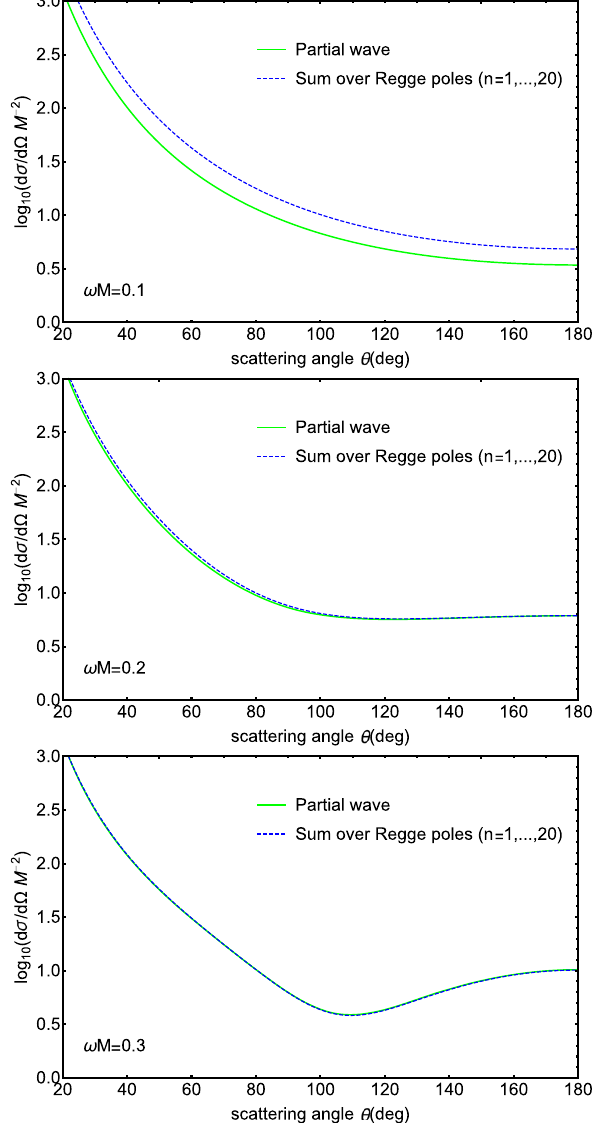
Fig. 9 Comparison of the scattering cross sections obtained via the partial wave method and the Regge pole approximations for ω M = 0 . 1 (top), 0.2 (middle), and 0.3 (bottom). We set q =